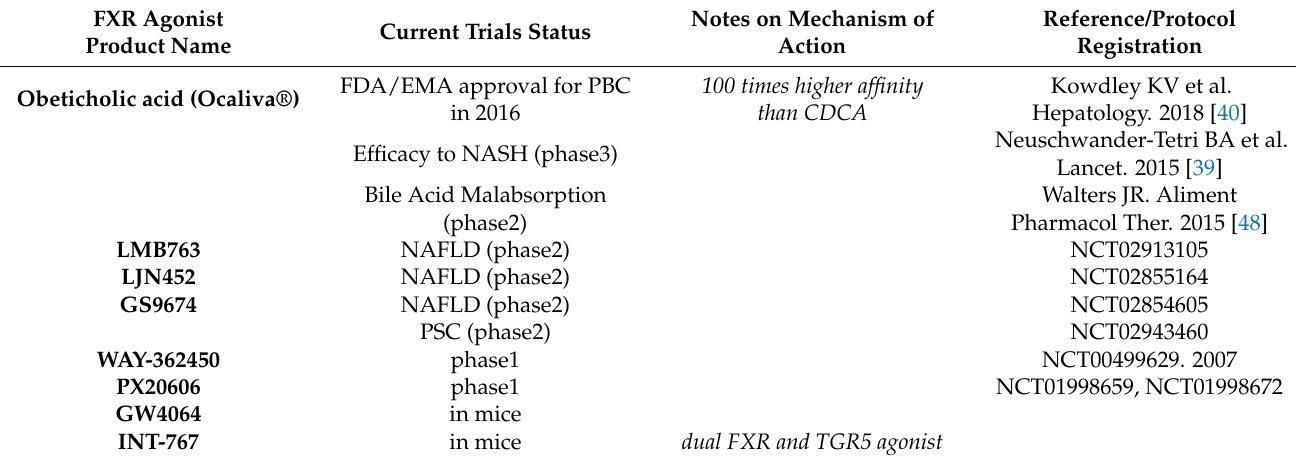
Table legend: PBC: primitive biliary cholangiopathies; NASH: non alcoholic steato-hepatitis; NAFLD: non alcoholic fatty liver disease; PSC: primary sclerosing cholangitis; CDCA: chenodeoxycholic acid; TGR5: G protein-coupled bile acid